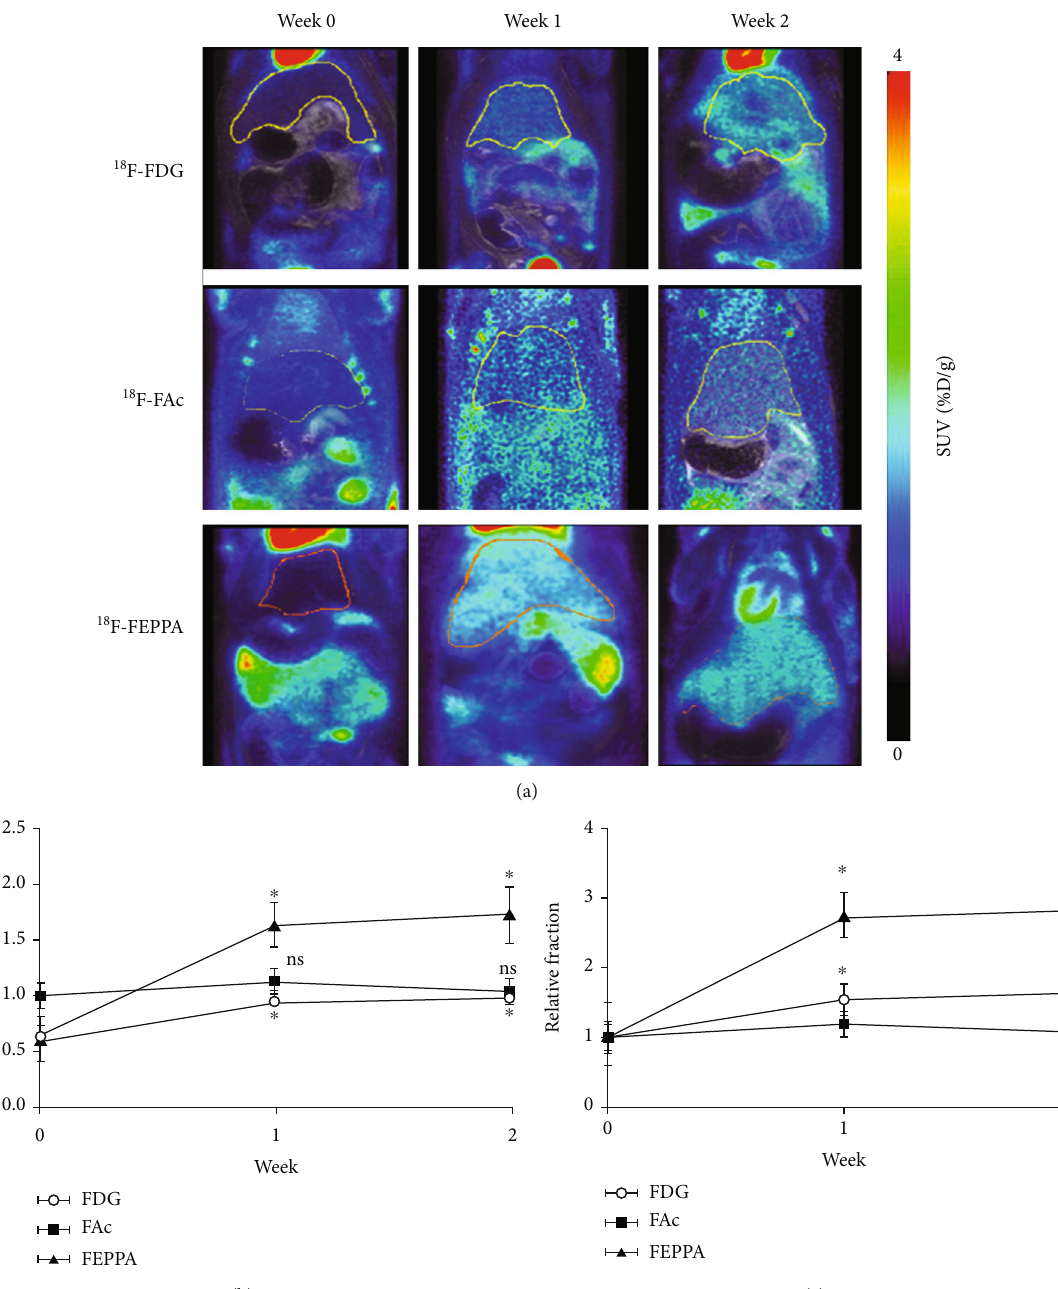
Figure 2: Accumulation of radioactivity in rats before and after bile duct ligation (BDL). (a) PET-MRI fusion images of representative rats before and after BDL. The solid lines on the PET-MRI fusion images indicate manually drawn liver ROIs. (b) The comparisons of the standard uptake value (SUV) of radioactivity at 0, 1, and 2 weeks after BDL. (c) The relative fraction of SUV compared to that at week 0 for each radiotracer. Data are presented as mean ± standard deviation . ∗ Signi fi cantly di ff erent when compared to that before resolution = 0 : 36 × 0 : 42 × 1 mm 3 , and number of slices = 50 . The scanning sequences for T2W images were as follows: repetition time/echo time = 4164 ms/24.7 ms, number of average = 4 , spatial resolution = 0 : 22 × 0 : 25 × 1 mm 3 , and number of slices = 50 . Heart and breath rates were recorded during the entire experiment, and body temperature was maintained using a warm water blanket.